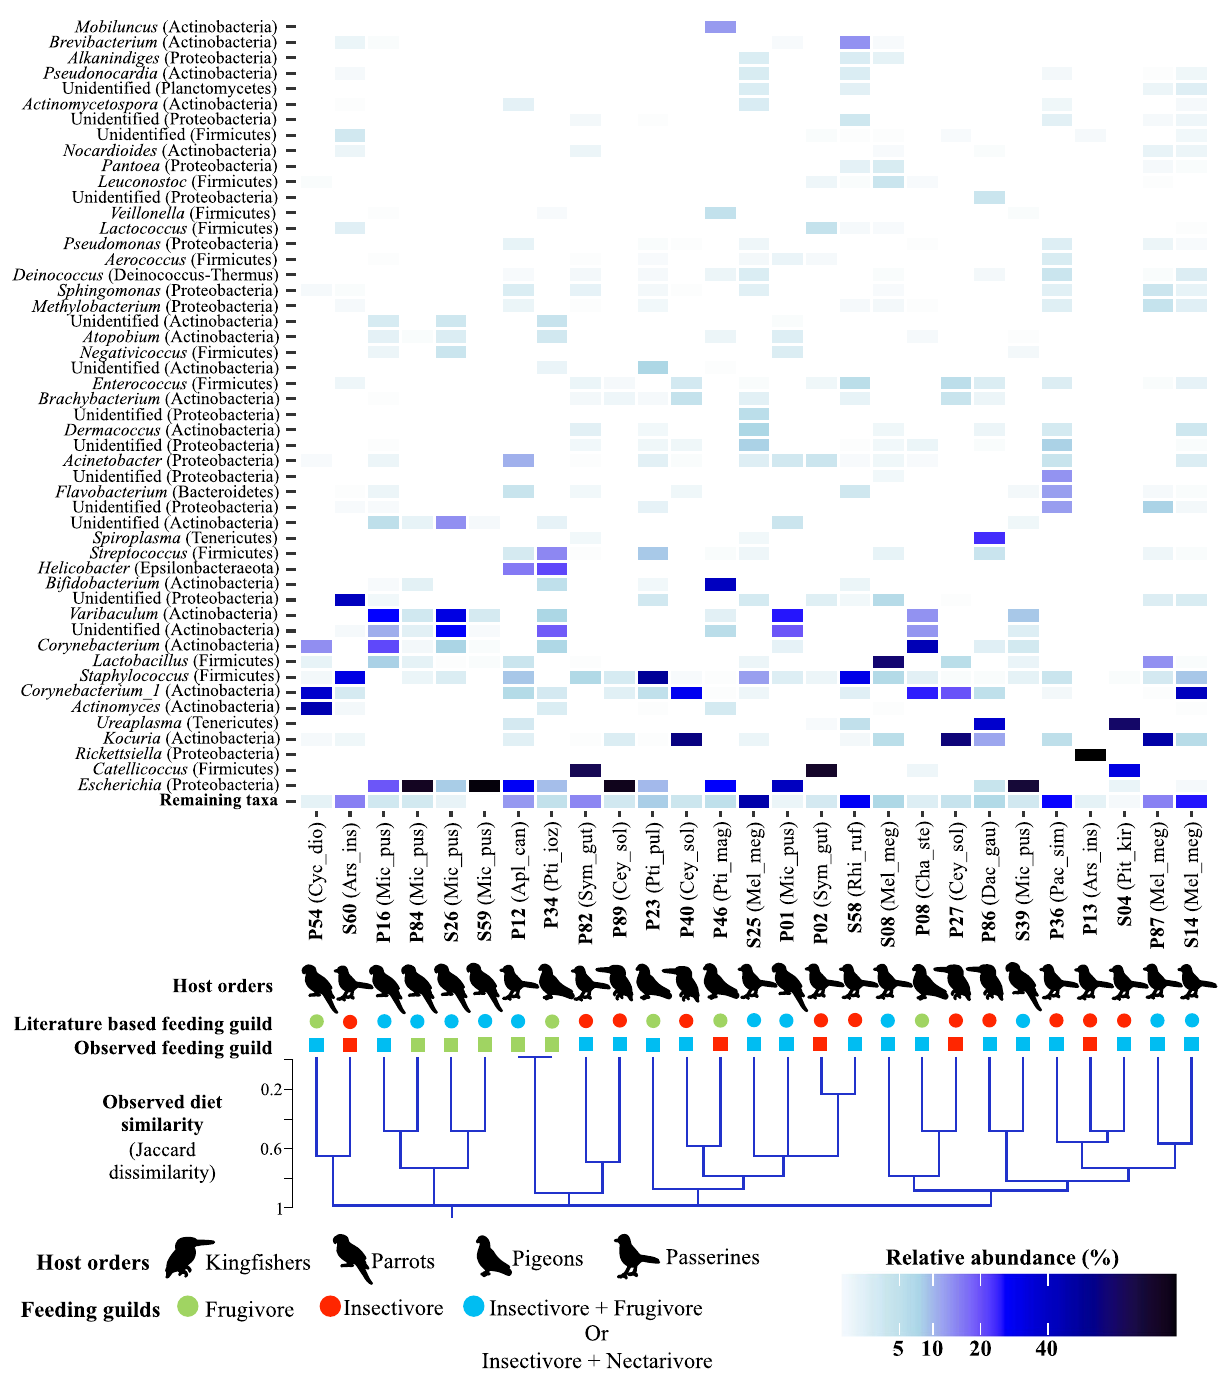
Figure 3. Overall cloacal microbiomes were not influenced by the observed diet similarity of individuals. The heatmap depicts the relative abundance of the 50 most abundant bacterial genera in the cloacal microbiomes. The dendrogram represents the consumed diet similarity (combined dataset) between individuals based on Jaccard distances. Literature-based dietary guilds and the observed feeding guilds of the individuals are indicated below the bird order icons. Insectivore + Frugivore and Insectivore + Nectarivore dietary guilds have been combined since none of the diet identification methods was able to identify nectar. The species code of each individual is given near the host ID number (code names from Fig.